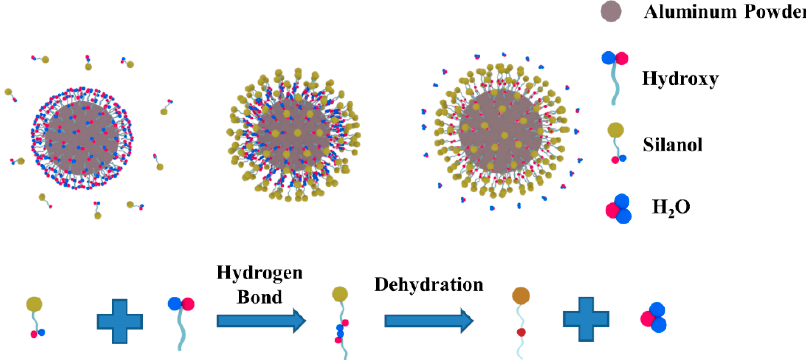
Figure 1. The schematic illustration of SiO 2 @Al synthesis.